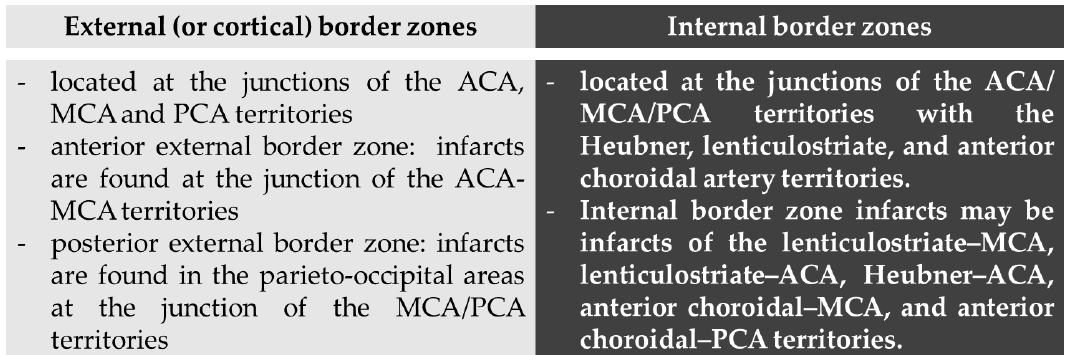
5 Abbreviations: CPR: C-reactive protein; CTA: Computed Tomography Angiography; EVT: Endo- Vascular Treatment; IVT: IntraVenous Thrombolysis; MRA: Magnetic Resonance Angiography; NIHSS: National Institute of Health; Stroke Scale; TIA: Transient Ischemic Attack; WBC: white blood cells; mRS: modified Rankin scale. 4. Discussion We report three patients with stroke as presenting symptom of hypereosinophilia from three different causes, two of them fulfilling the criteria for HES [1]. The pathophys- iological mechanisms of stroke in the context of hypereosinophilia may produce a com- posite pattern on neuroimaging studies, ranging from a large vessel occlusion (or territo- rial) pattern [8] to multiple scattered lesions in several different vascular territories, and in particular in border zones [5,6,9,10]. These last ones may be considered a hallmark of HES-related stroke, in particular without evidence of hemodynamic unfavorable condi- tions, being caused by a direct toxic effect of the increased number of circulating eosino-